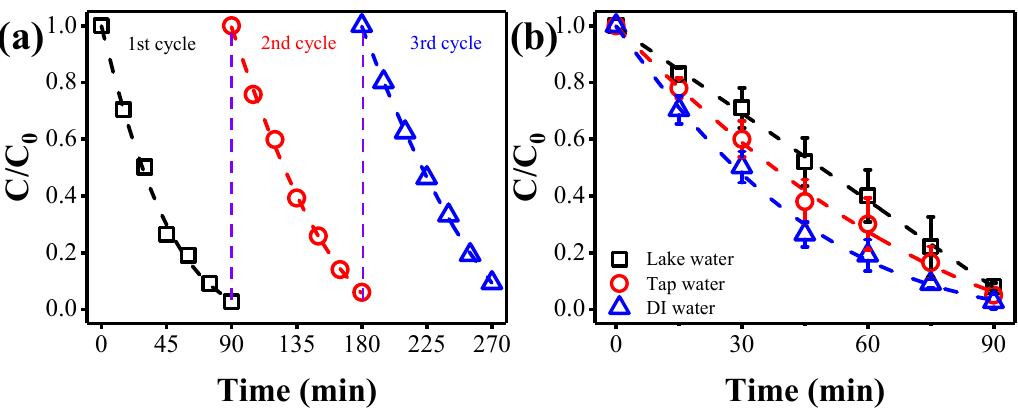
Figure 4. ( a ) Comparison of ammonia conversion kinetics during three consecutive cycles. ( b ) Impact of background solutions on the ammonia removal. Reaction conditions: ammonia of 30 mg · L − 1 , anode potential of 2.8 V vs. Ag / AgCl, flow rate of 1.5 mL · min − 1 , [Cl − ] of 0.14 M, and pH 9.